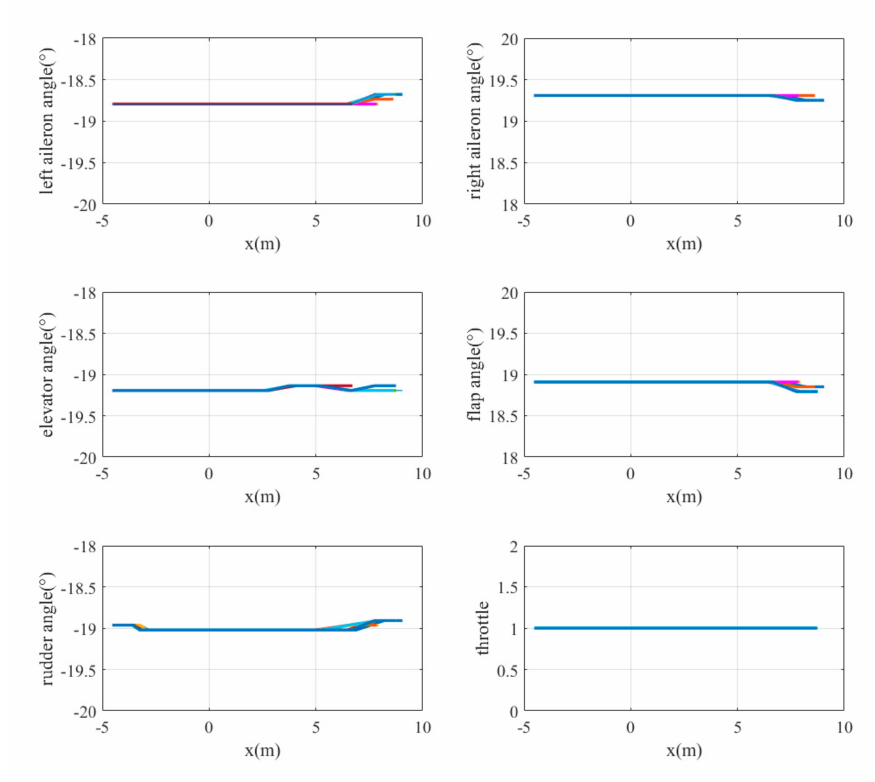
Figure 20. The control commands for the actuator under case